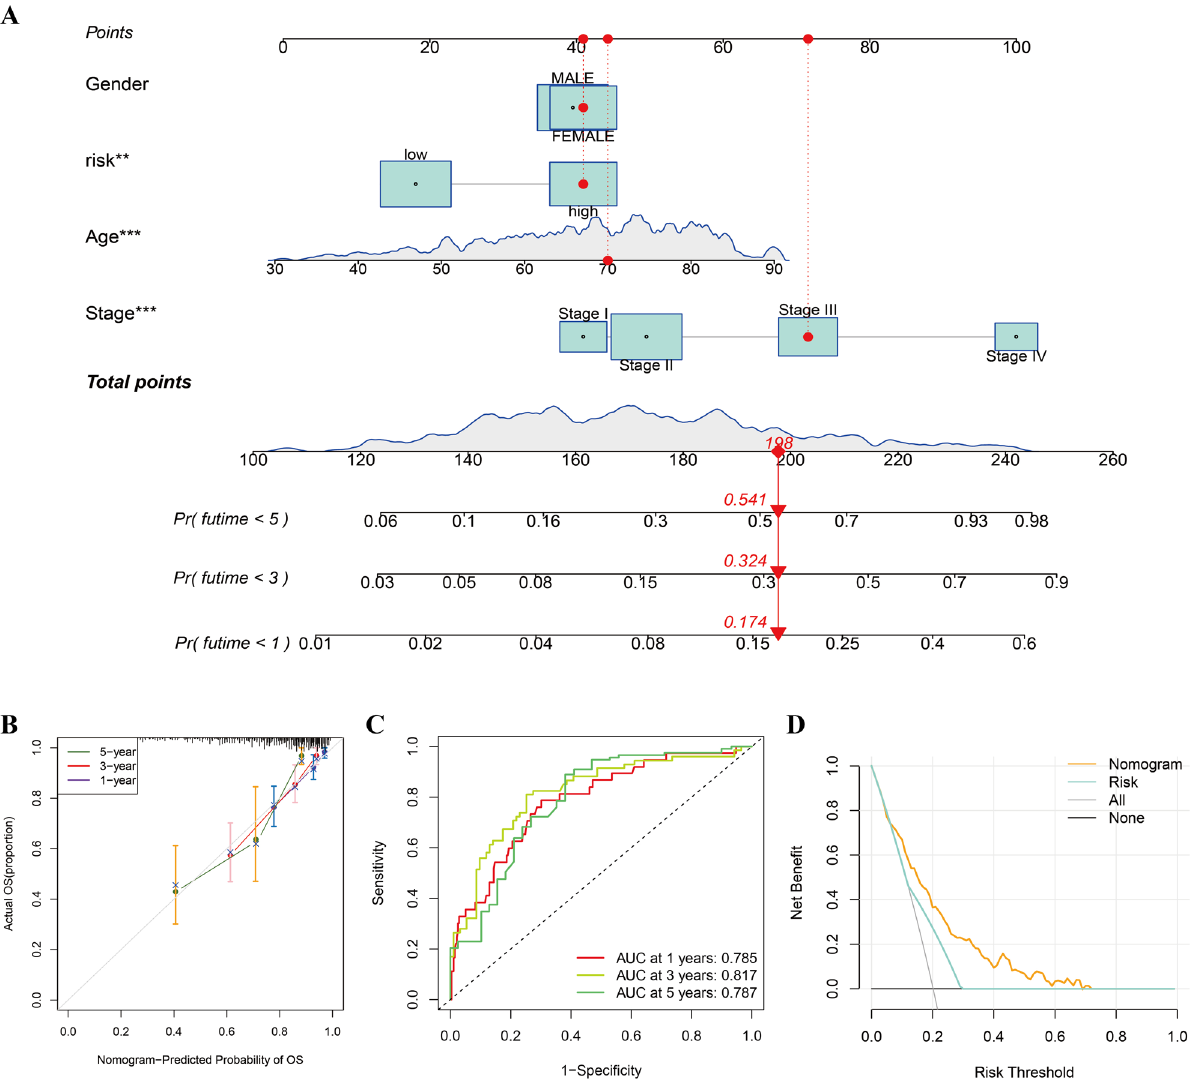
Figure 8. Construction of the nomogram. ( A ) Nomogram for the prediction of 1-, 3- and 5-year OS in COAD patients, ** p < 0.01, and *** p < 0.001. ( B ) Calibration curves of the nomogram. ( C ) Time-dependent ROC curves of the nomogram. ( D ) Decision curve analysis of